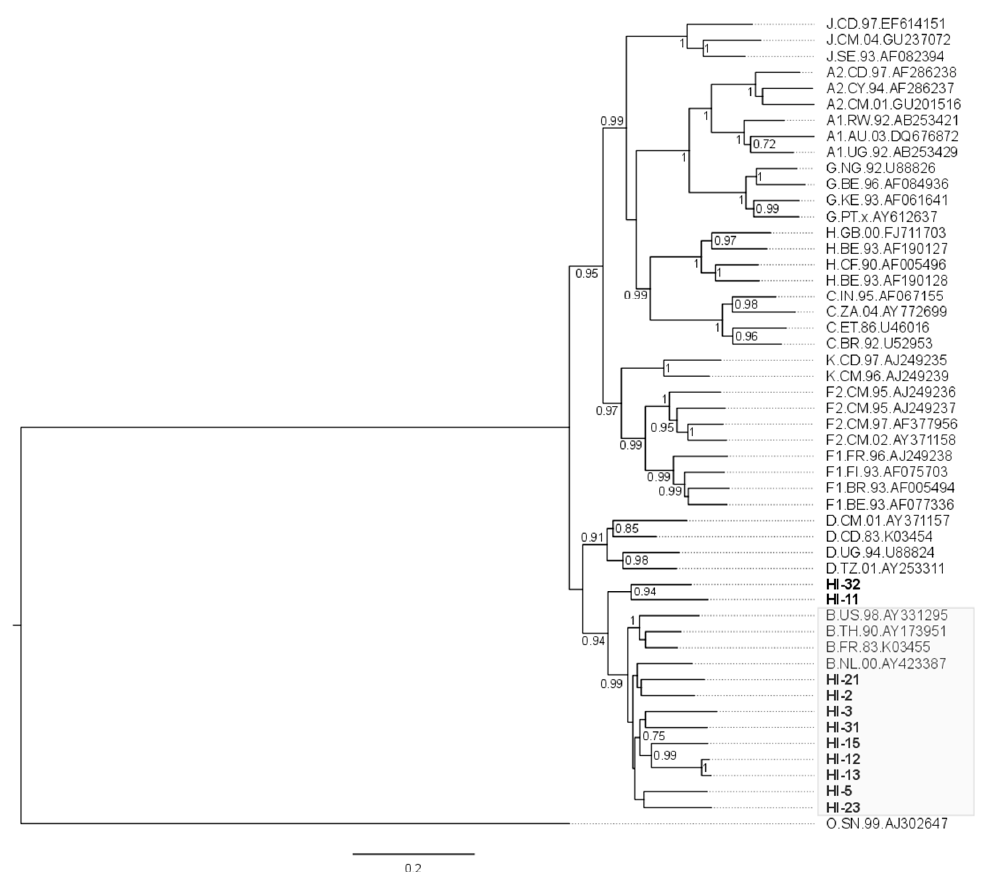
Figure 1. Phylogenetic maximum likehood analysis of HIV near full-length genomes obtained in this study. The analysis was conducted with 1000 bootstrap iterations and included eleven HIV-1 proviral sequences from Hospital Federal de Ipanema, Rio de Janeiro (represented in bold) and references of HIV-1 subtypes (represented by the subtype, country, year and GenBank accession number). Only bootstrap values greater than 0.7 are shown. The gray box highlights the sequences classified as subtype B, among which nine of the eleven sequences were placed. The two remaining sequences represented unique recombinant forms comprising subtype B and other subtypes.